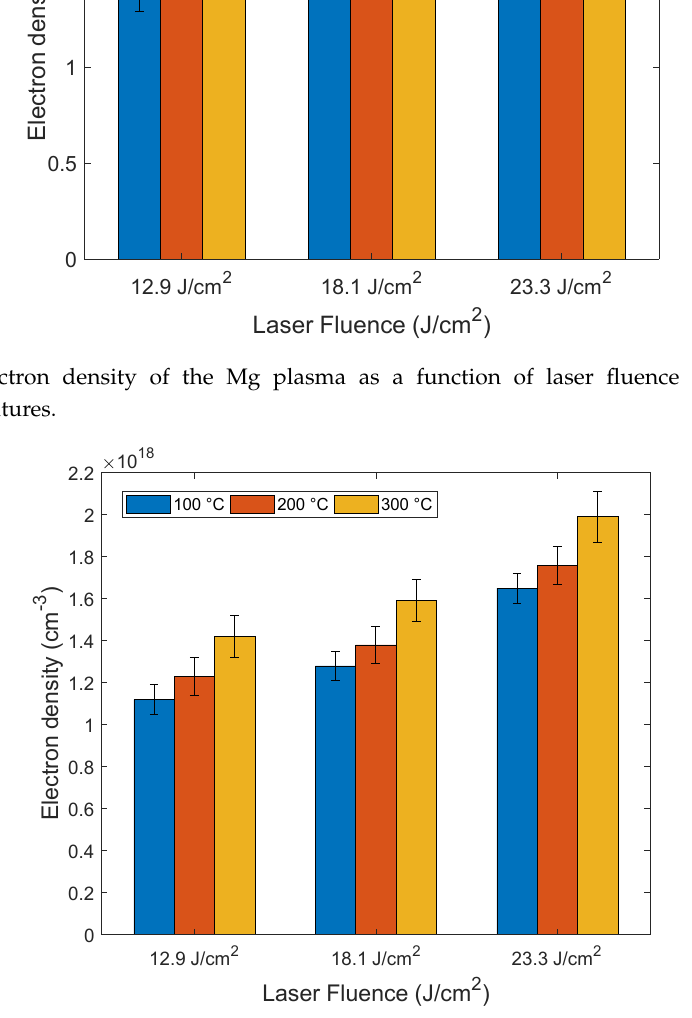
Figure10. ElectrondensityoftheTiplasmaasafunctionoflaserfluenceatdi ff Figure 10. Electron density of the Ti plasma as a function of laser fluence at different sample temperatures.